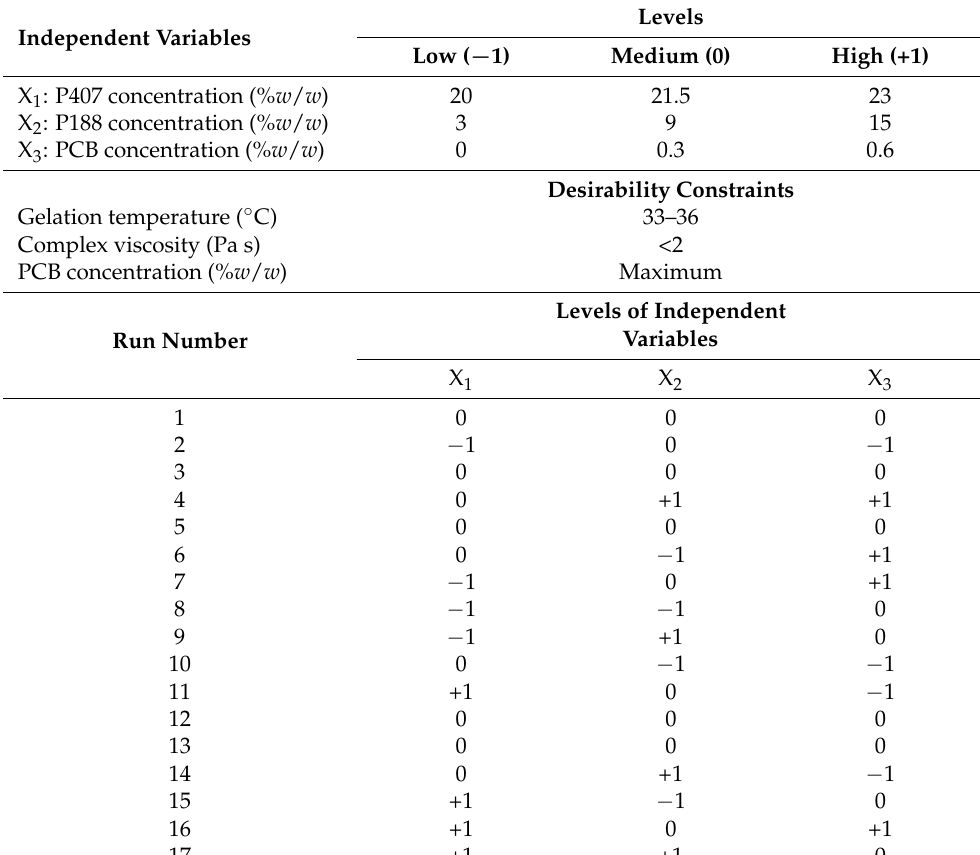
Table 1. Variables and Box–Behnken